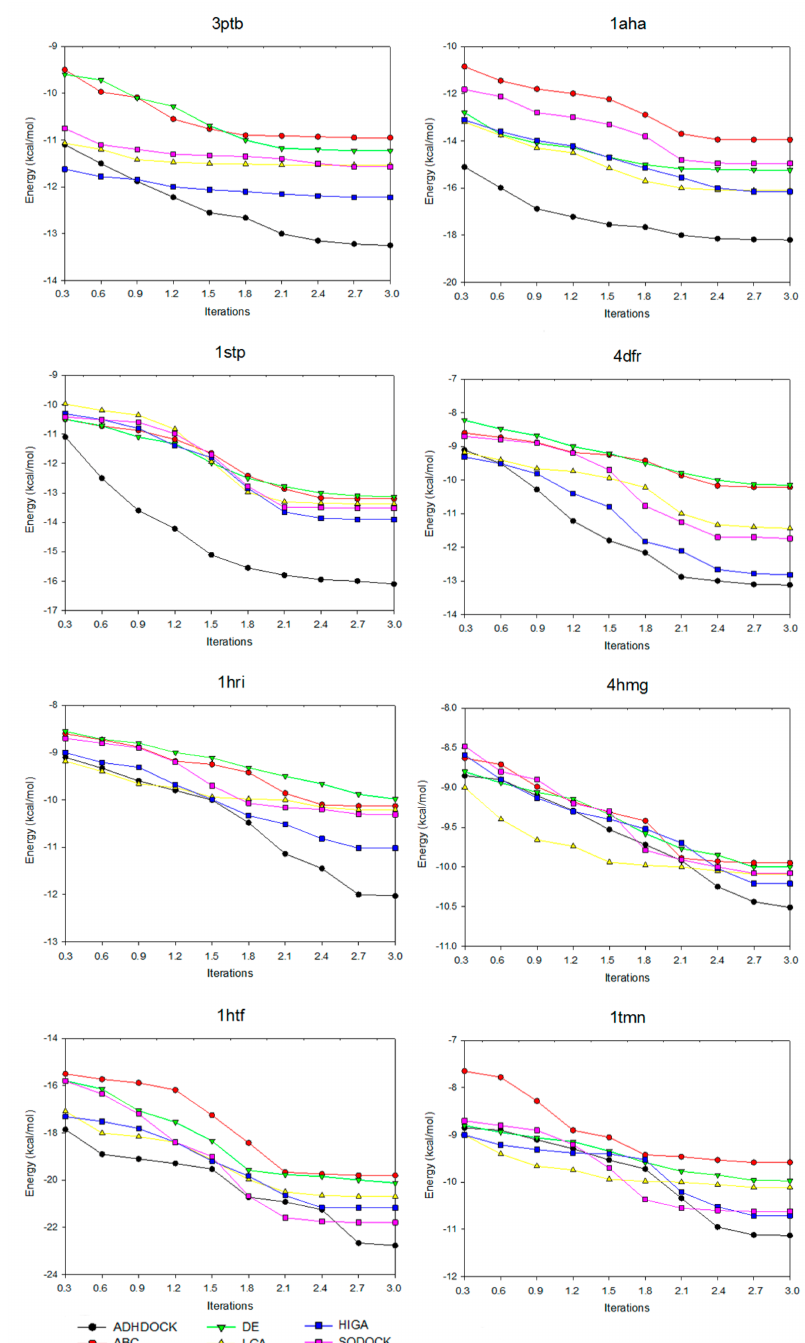
Figure 2. Convergence diagrams of six tested